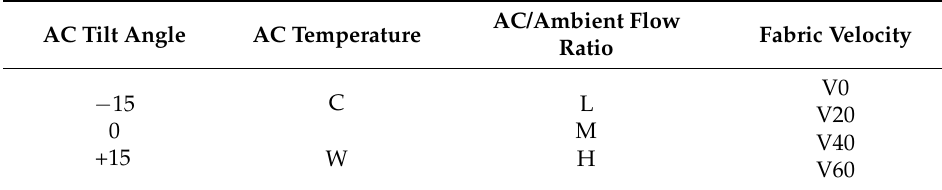
Table 3. Coding scheme based on the parameters from Table